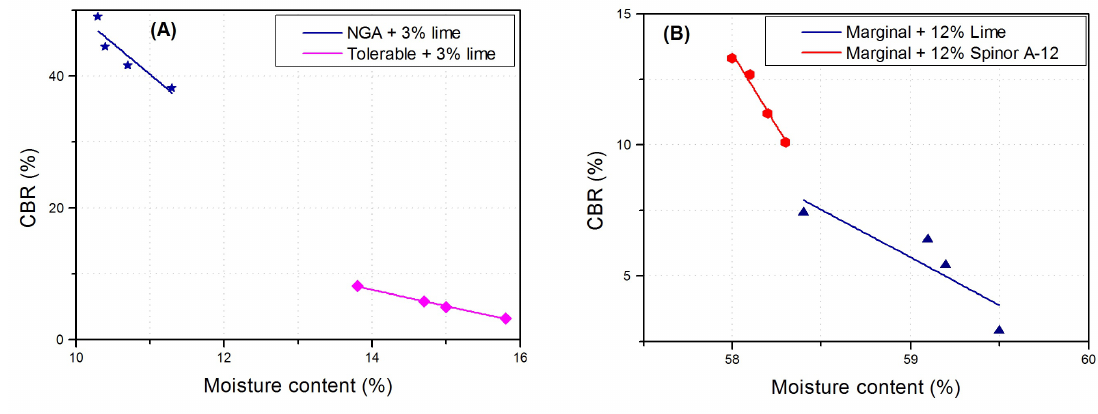
Figure 6. CBR versus moisture content for ( A ) NGA and tolerable soils stabilized with lime, and ( B ) marginal soil stabilized with lime and